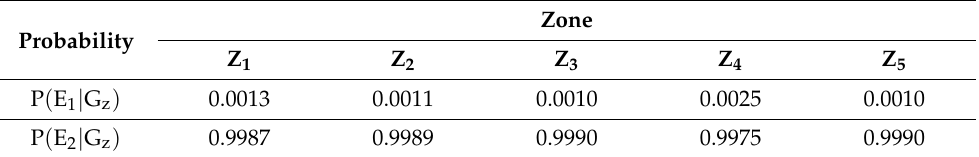
Table 23. The calculated probability of type I and type II earthquakes in cluster type I.